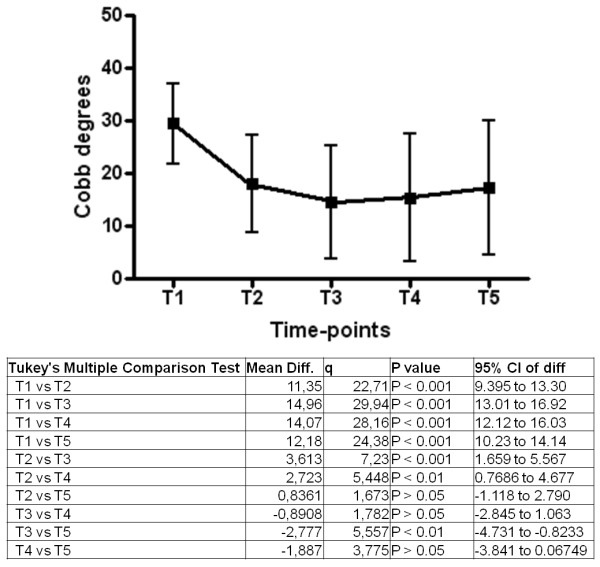
Changes in CM over time in the whole study sample (n = 113).